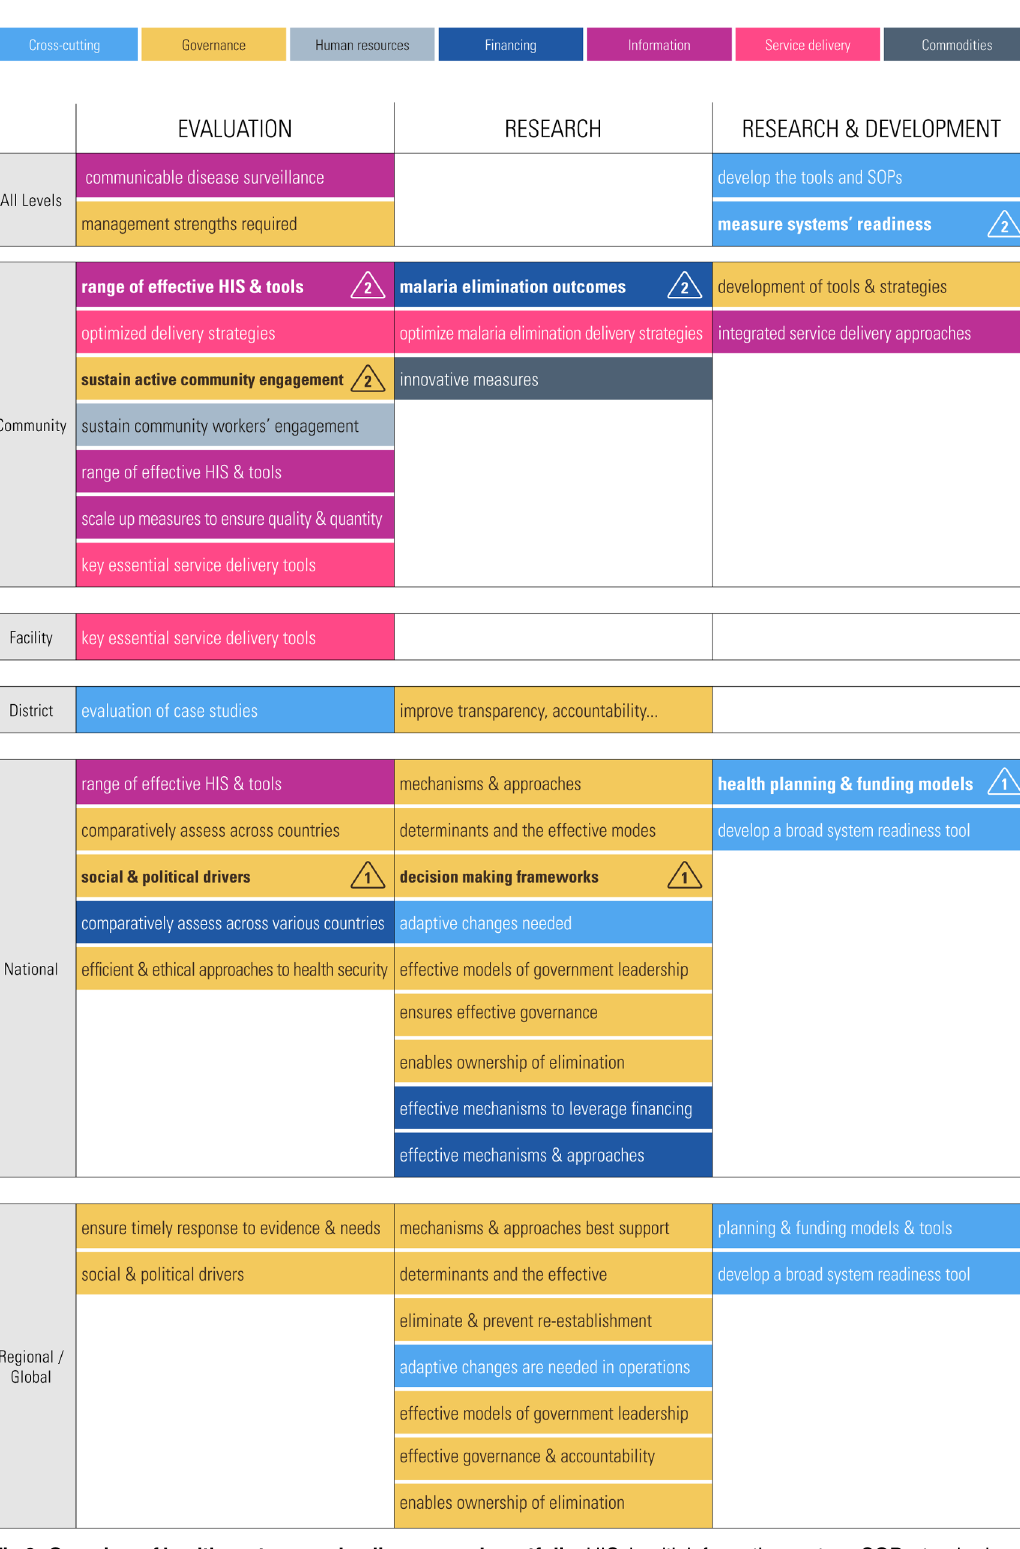
PLOS Medicine| https://doi.org/10.1371/journal.pmed.1002454 November30,